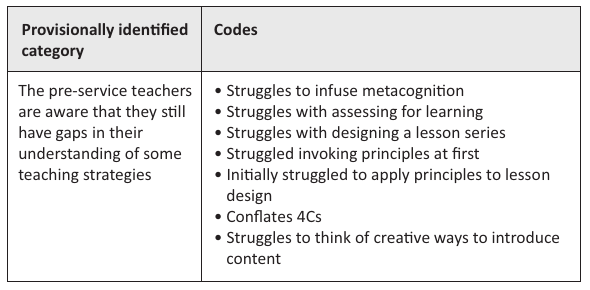
FIGURE 2: Example of how codes were sorted into provisionally identified